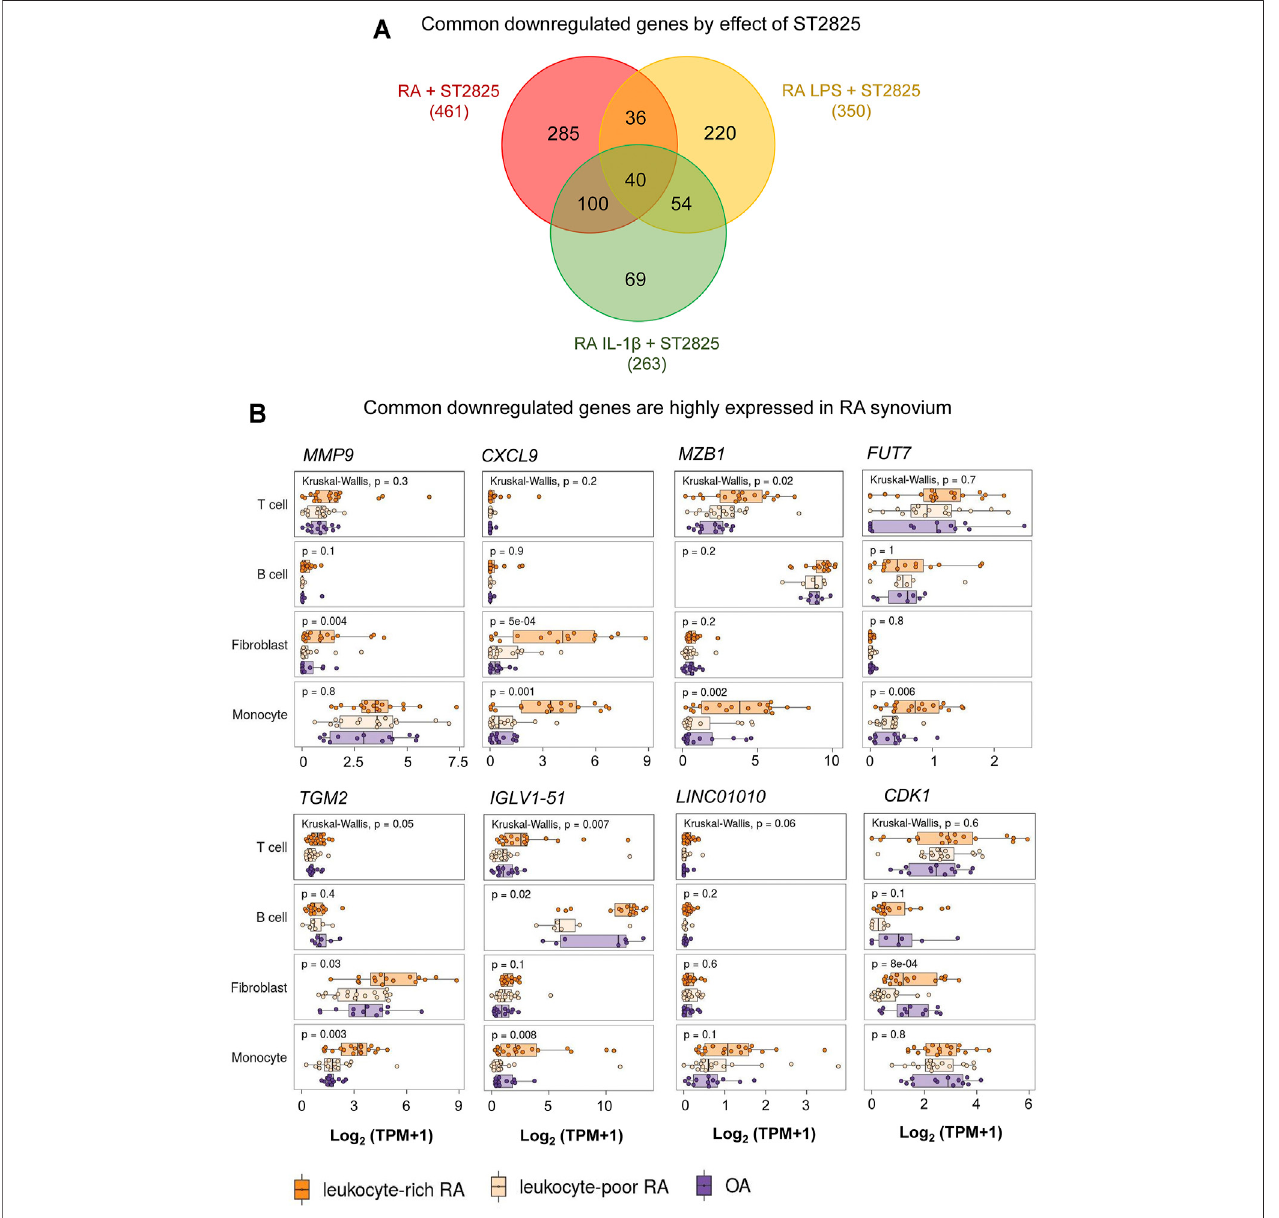
FIGURE 5 | RNA-seq comparison reveals that highly expressed genes in RA synovium could be potentially downregulated by ST2825. (A) Venn diagram shows overlap among all sets of downregulated genes from RA PBMC (red), RA LPS-stimulated PBMC (yellow), and RA IL-1 β -stimulated PBMC (green) after treatment with ST2825. (B) Eight common downregulated genes by effect of ST2825 identi fi ed from RA PBMC were highly expressed by different cell types in the synovium of leukocyte-rich RA (orange), leukocyte-poor RA (tan) and OA (purple)